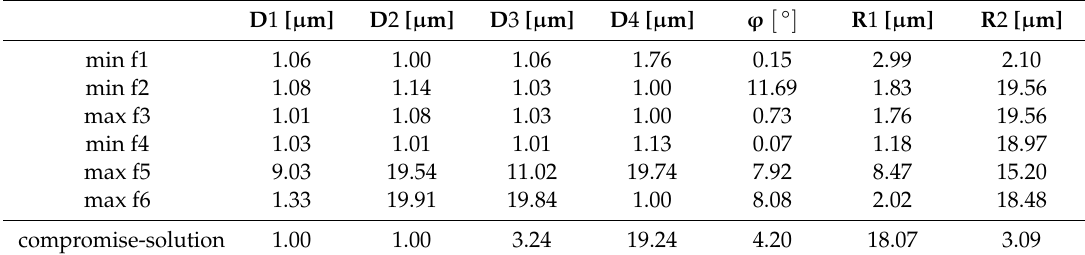
Figure 15. Shapes of the actuator for the extreme value of objective functional: ( a ) minimum f1, ( b ) minimum f2, ( c ) maximum f3, ( d ) minimum f4, ( e ) maximum f5 and ( f ) maximum f6. Table 3. Results of the optimization—values of the design